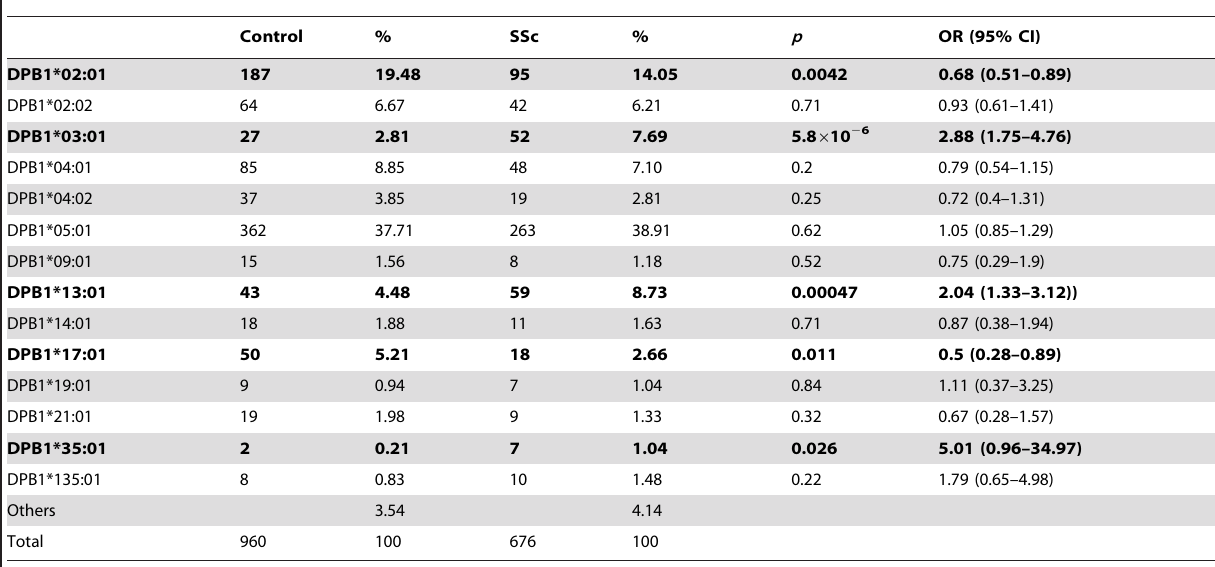
Table 1. Distribution of major HLA-DPB1 alleles in Chinese controls and SSc